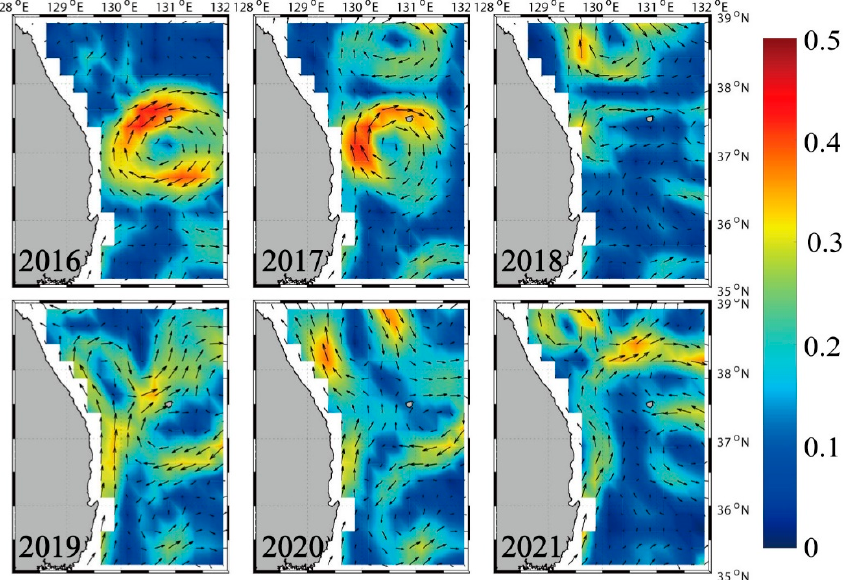
Figure 5. Inter-annual changes in surface geostrophic current (m/s) in the western part of East/Japan Sea (WES).